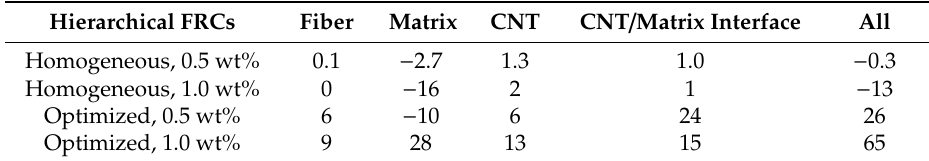
Table 2. The relative di ff erence of the strain energy (in %) of a hierarchical FRC compared to that of pristine FRC, and the contribution from each constituent material (defined by Equation (6)). Hierarchical FRCs Fiber Matrix CNT CNT / Matrix Interface All Homogeneous, 0.5 wt%